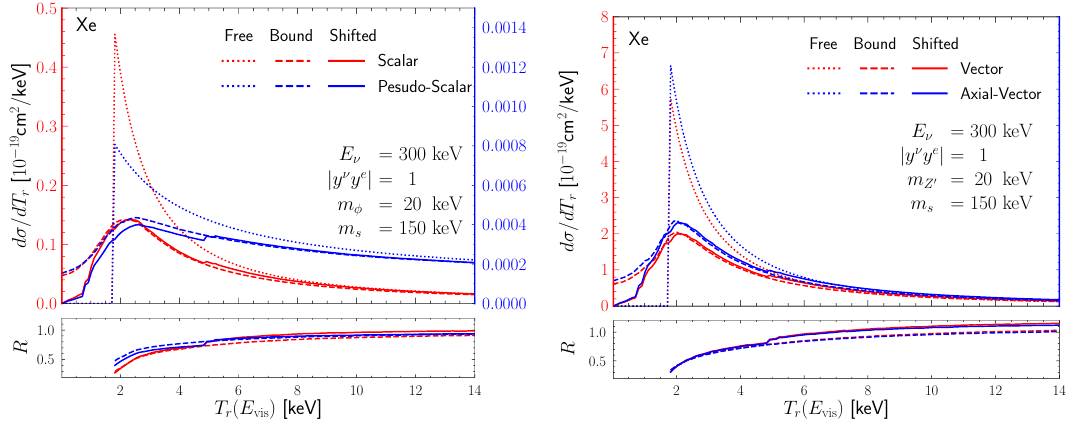
Figure 5 . The differential cross section of neutrino scattering with all electrons of Xe atom into a massive sterile neutrino. The left panel shows the case with scalar (red) and pseudo-scalar (blue) mediators. For comparison, we also show the vector mediator case in the right panel with vector (red) and axial vecctor (blue) couplings. Both panels show the results with free (dotted), bound (dashed), and the shifted one including recombination energies (solid). The enhancement from the free electron scattering cross section is shown as ratio R in the lower panels for comparison. Since the couplings only appear as overall factor, we adopt | y ν y e | = | g ν g e | = 1 for simplicity. in the upper panels of figure 5. As discussed below (3.7), the matrix element part is approximately 4 m E 2 / (2 m T + m 2 ) 2 for the free electron scattering with vector mediator. e e r ν Z 0 For comparison, the scalar case has m (2 m T + m 2 ) / (2 m T + m 2 ) 2 . With tiny e e r e r s φ